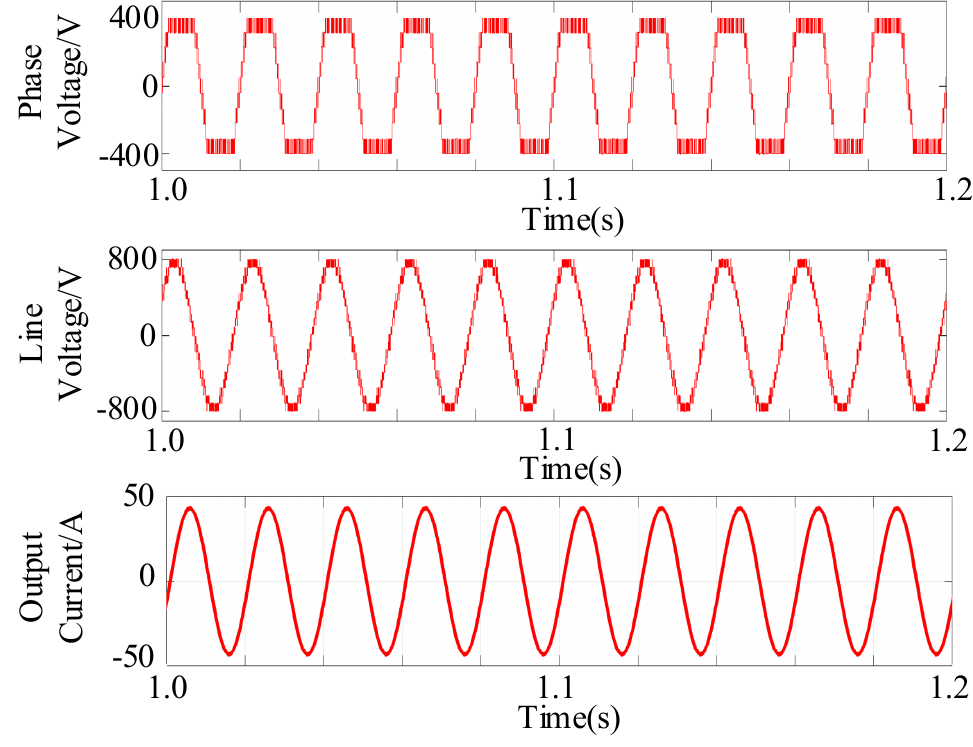
Figure 10. Simulated waveforms (type u fault). Table 4. The values of line